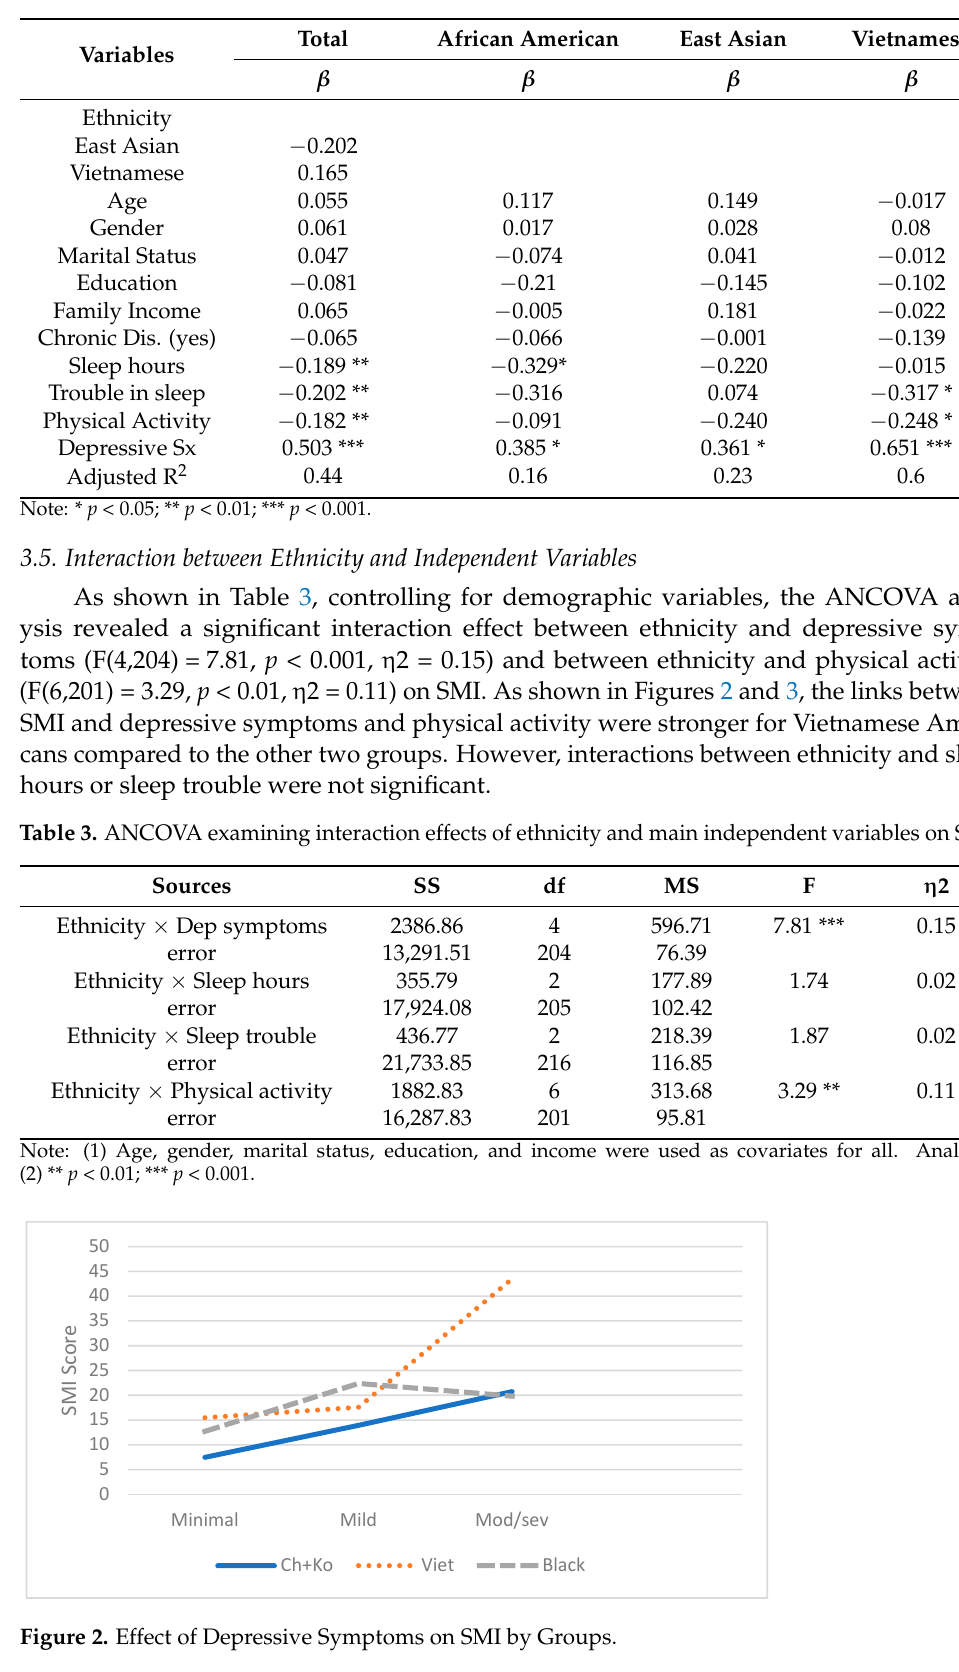
Table 2. Factors associated with SMI by ethnic groups.